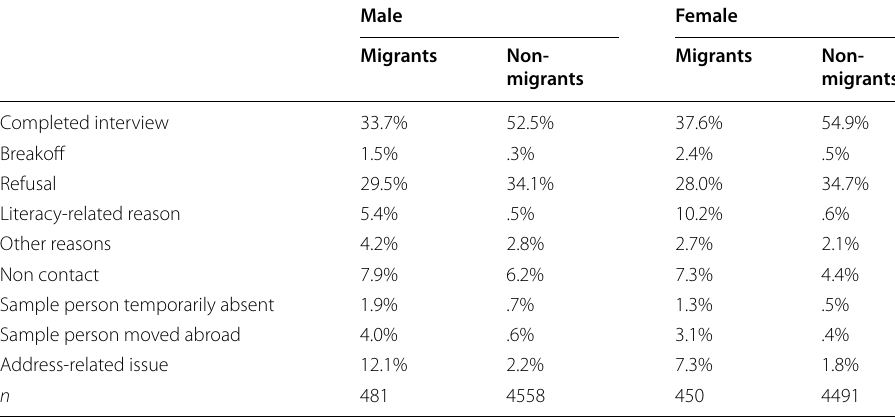
Table 3 Disposition codes for PIAAC Germany by migration status and